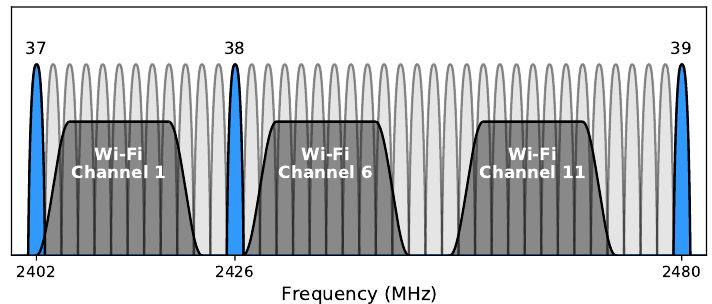
Figure 1. BLE and Wi-Fi channels at the unlicensed 2.4 GHz ISM